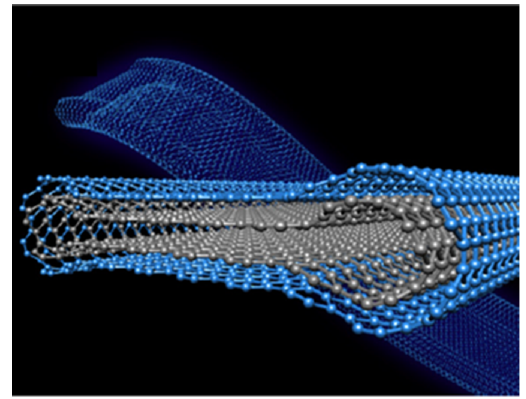
Figure 27. A scheme illustrating the structure of carbon nanobelt [231]. Reprinted with permission from Ref. [232]. Copyright © 2023 Elsevier Ltd. All rights reserved.